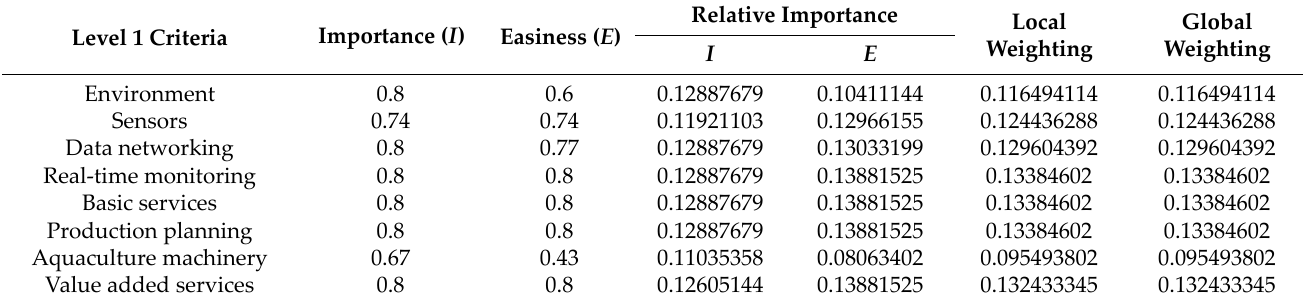
Table 5. The priority evaluation of Level 1 criteria using the modified AHP.